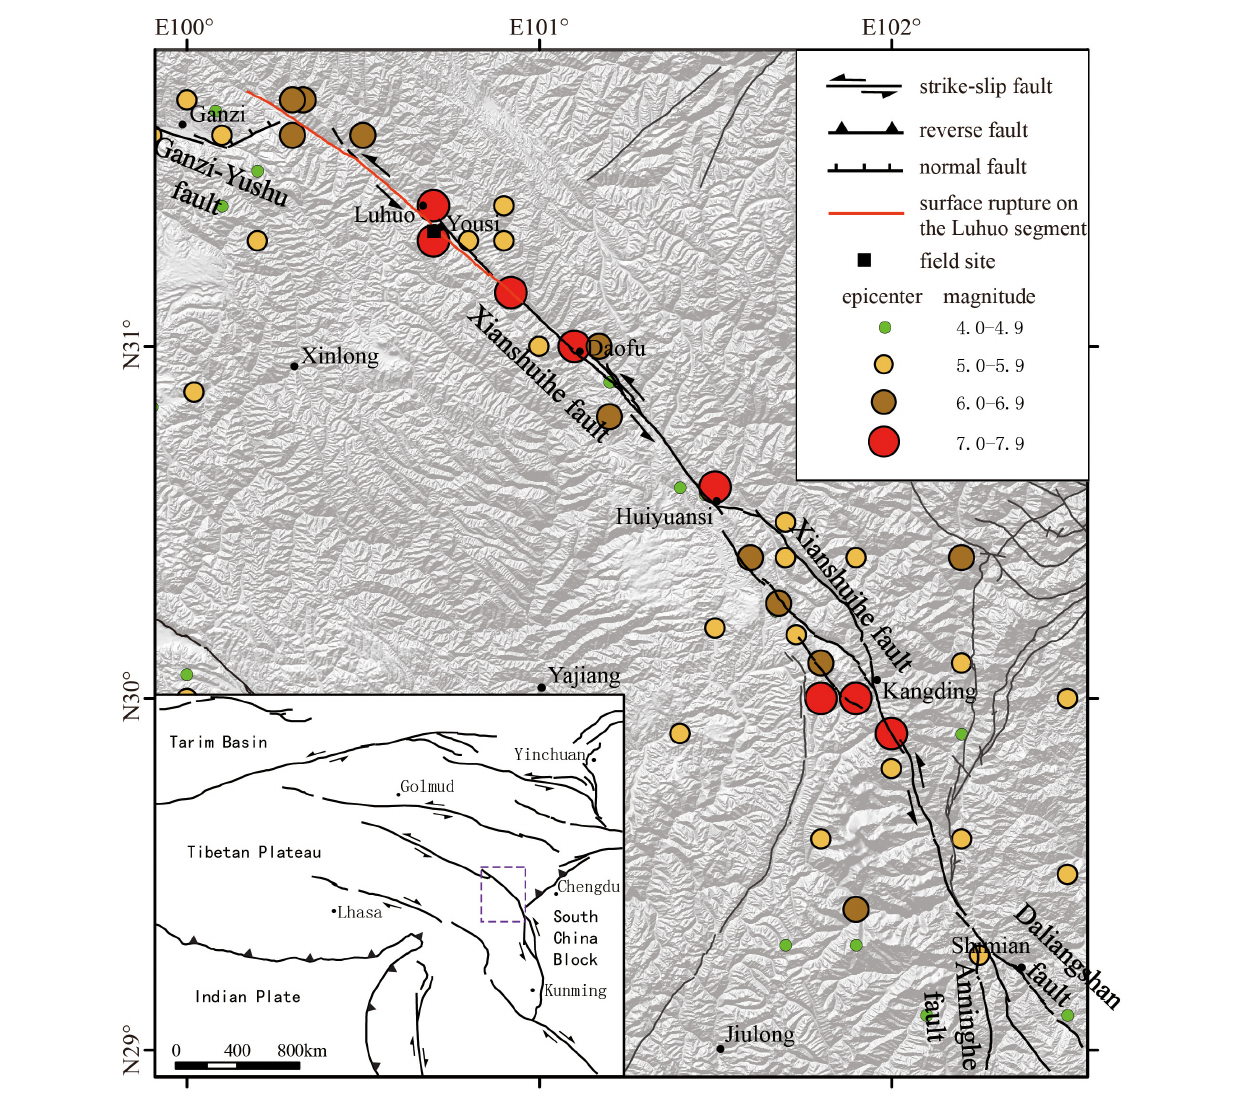
FIGURE 1 | Grayscale map (modified from 90-m-resolution SRTM4 data) showing the topographic and tectonic setting of the Xianshuihe fault. The earthquake catalog was provided by Sichuan Earthquake Agency, Chengdu, China. The fault line was modified from Li et al.